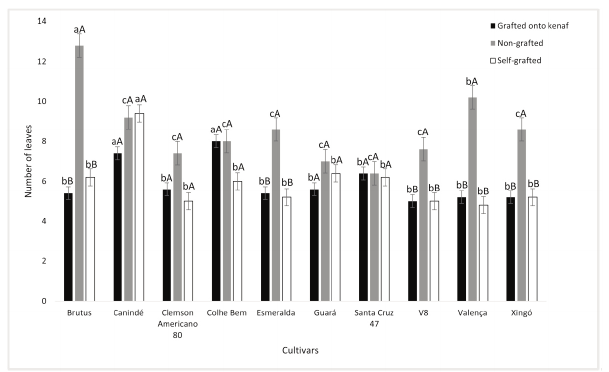
Fig. 2 ­ Interaction between cultivars and seedling production modality for the number of leaves. Means followed by the same uppercase (between seedling production modalities for each cultivar) and lowercase (between cul­ tivars for each seedling production modality) letter do not differ by the Scott­Knott test